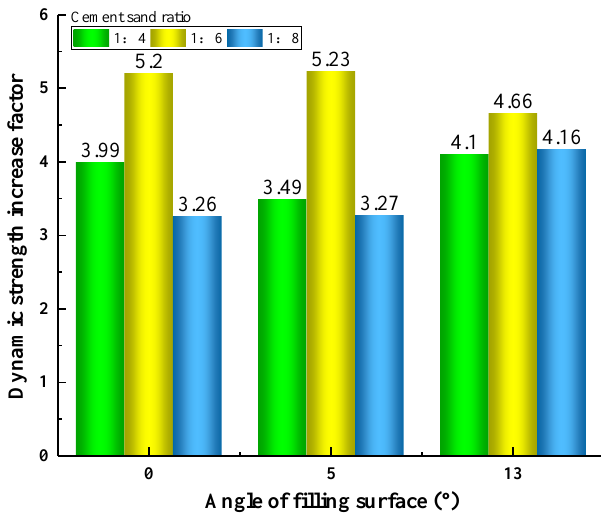
Figure 13. Relationship between the angle of the filling face and the dynamic strength growth fac- tor.